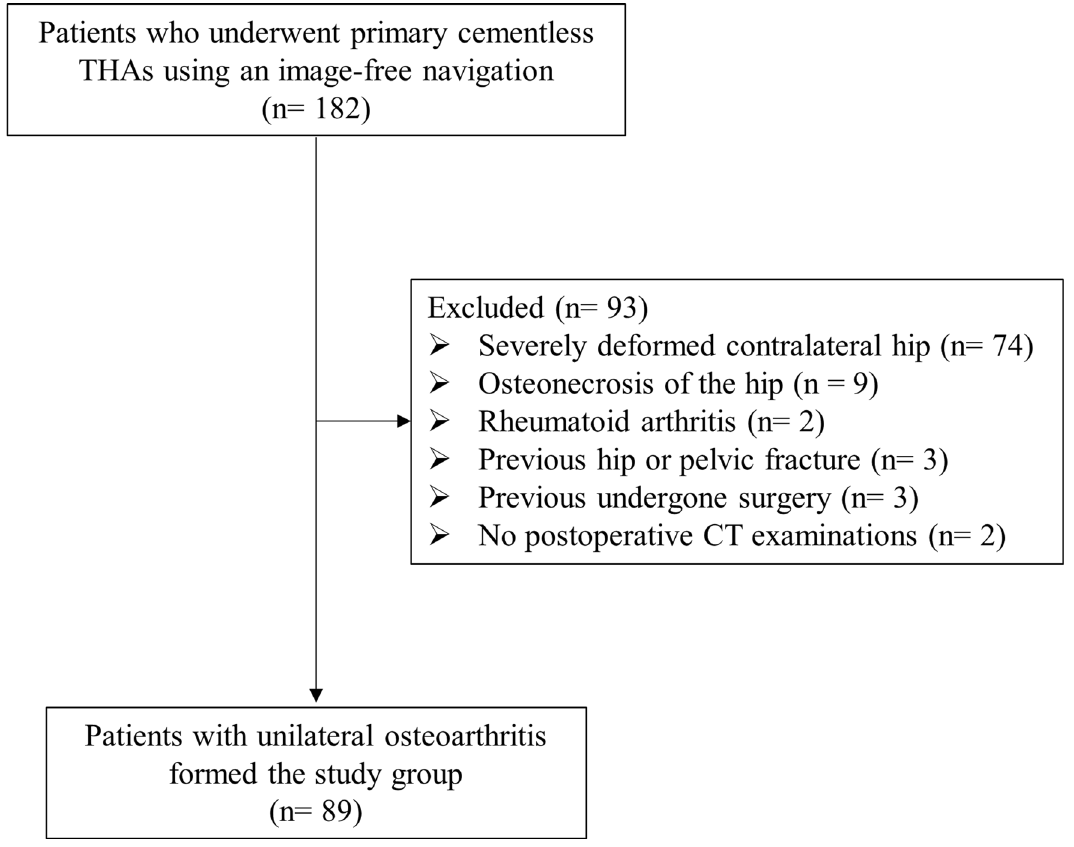
Figure 1. Patient flow